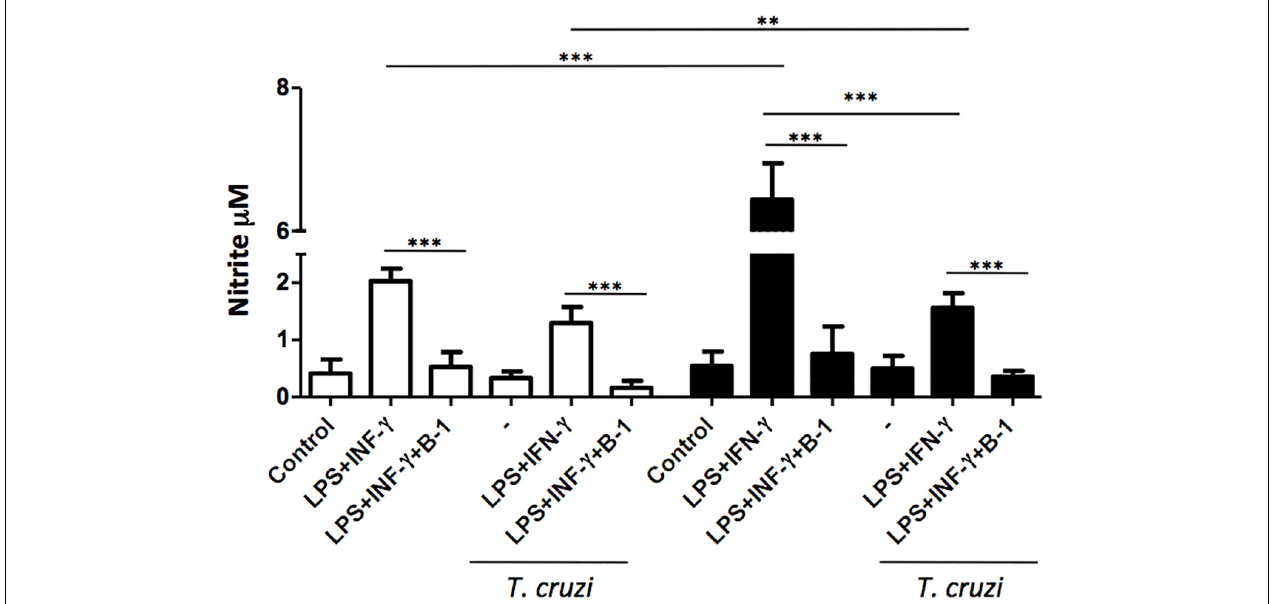
FIGURE 2 | The production of nitric oxide in macrophage: B-1 cell co-cultures. Peritoneal macrophages from BALB/c (white bars) or from XID mice (black bars) were plated (2 × 10 5 /mL) and infected with trypomastigotes forms of T. cruzi Dm28c clone at a 5:1 parasite-to-cell ratios in 1 mL of DMEM 10% FCS and incubated at 37 ◦ C in 5% CO 2 . After overnight incubation, the cell culture was washed and some cultures were co-cultivated with B-1 cells at a 10:1 B-1-to-macrophages ratios and stimulate or not with LPS (400 ng/mL) and IFN- γ (1.5 ng/mL). After 24 h, the NO was measured in the supernatants of the cultures by the Griess method. All cultures were performed in triplicate and bars show the mean + SD. Statistical analysis was performed by t -test from representative results of three similar experiment ( ∗∗ p < 0.01 and ∗∗∗ p < 0.001).